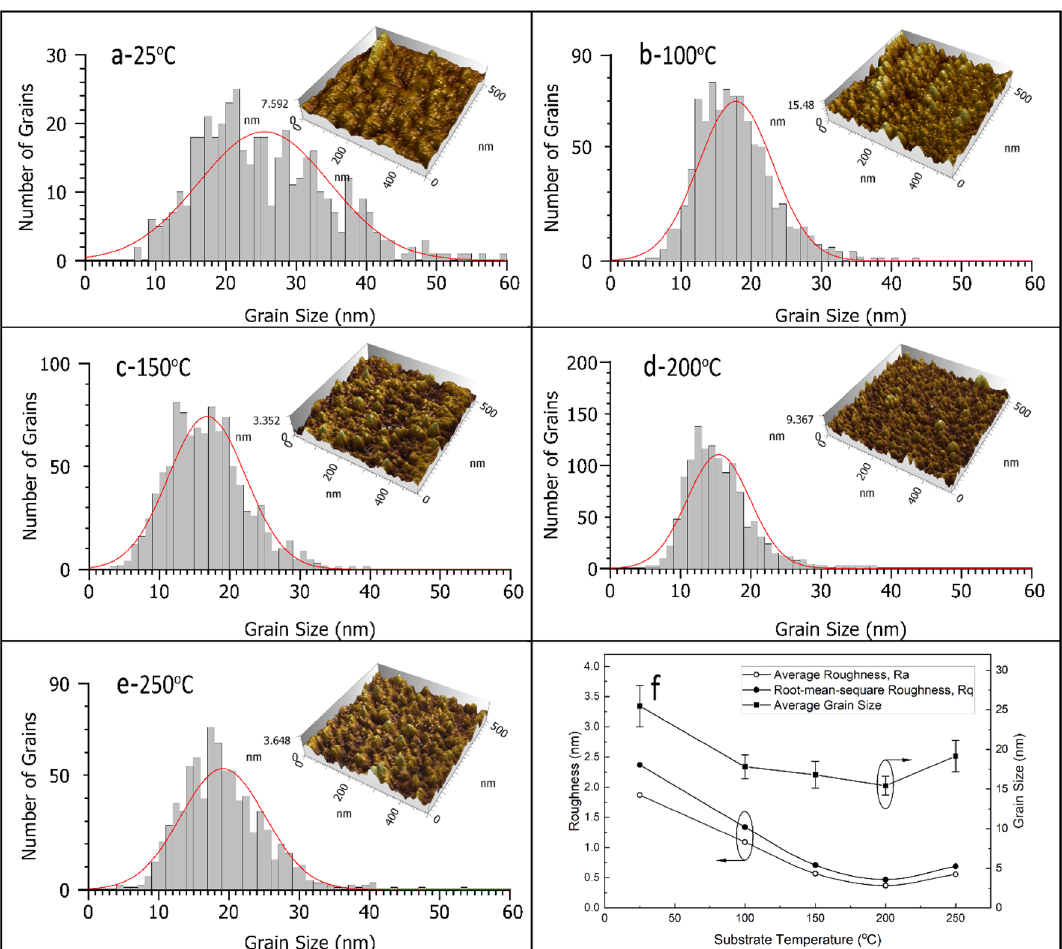
Figure 1. ( a – e ) 3D AFM topography images and grain size distributions histogram with fitted Gaussian curves for the coated films produced using a different deposition temperature of: ( a ) 25 °C, ( b ) 100 °C, ( c ) 150 °C, ( d ) 200 °C, and ( e ) 250 °C, and ( f ) variation of grain size, Ra and Rq with substrate structure evolution. These results are in good agreement with those previously reported on the effect of substrate temperature on the roughness parameters for the reactive sputtered nitride films 49,55 . As we have previously mentioned, the optimum optical performance of the ARCs for solar cells is highly dependent on the precise control of film thickness and refractive index, as well as the morphology of the coating layer. The surface morphology and fractured cross-sections (as shown in the inset of Fig. 2) of the carbon nitride thin films prepared at different deposition times (30, 60, 120, and 180 min.) on silicon substrates at 200 °C are shown in Fig. 2. From the FESEM images, it can be seen that the surface morphologies of the as-deposited films on the silicon substrate were composed of very homogeneous fine-sized grains uniformly distributed over the film surface. For films deposited at of 30 min., the films exhibit an aggregation of grains distributed over an island structure, which indicates that the microstructure is in an early stage of film growth 53,56 . This is thus the threshold time at which the sputtered carbon nitride films have homogeneous surface morphology. When the deposition time is increased further, the surface structure becomes smoother and more densely packed with grains, with a corresponding increase in the film thickness. An obvious variation in the thickness and surface morphology of the film with deposition time was observed. The thickness of the film increased quite linearly from 23 to 137 nm as the deposition time increased from 30 to 180 min. Figure 3a correlates the resulting thicknesses with the deposition time. A linear regression fit with a slope of around 0.75 ± 0.04 nm/min can be extracted, as can be seen in the figure. To investigate the concentration of nitrogen and carbon, EDS analysis was used to perform a quantitative analysis of the deposited carbon nitride films on a silicon substrate at different substrate temperatures. The results are illustrated in Fig. 3b, where the inset represents a zoomed section of the EDS spectra for the films in order to illustrate the X-ray lines of C:Kα and N:Kα, which are located at energies of 0.277 keV and 0.392 keV, respectively. The figure shows that the film consists of mostly carbon and nitrogen, with a small amount of oxygen con- tamination. Based on the experimental EDS results, a plot of the nitrogen atomic concentration to carbon (N/C ratio) against the substrate temperature and deposition time is shown in Fig. 3c. Non-linear correlations between the N/C ratio and substrate temperature have been observed. The N/C ratio ranges from 0.22 for the